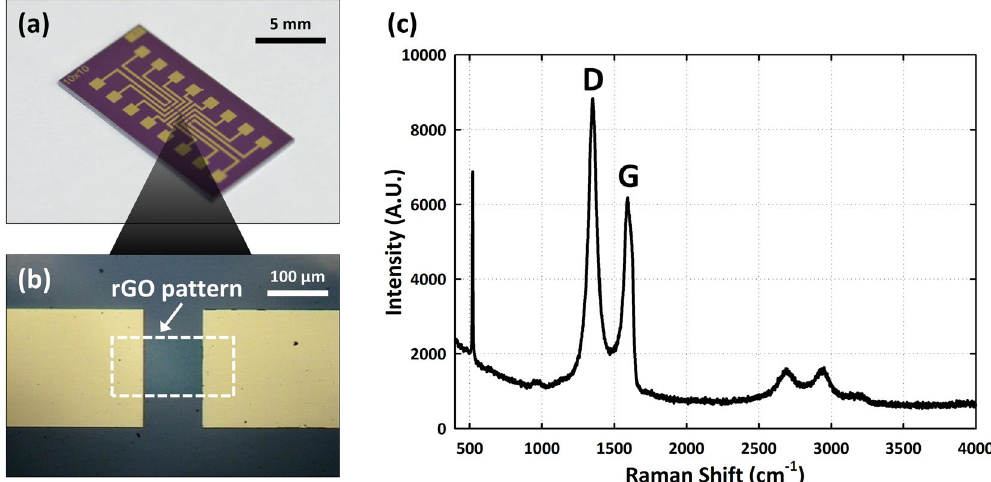
Figure 1. Illustrations showing details of the rGO sensor ( a ) enlargement of the board containing eight arrays for DNT detection; ( b ) location of the rGO sensor (200 μ m wide by 100 μ m long) between two Au electrodes. ( c ) Raman spectrum of the rGO sensor clearly showing the D and G bands at 1350 cm − 1 and 1580 cm − 1 ,